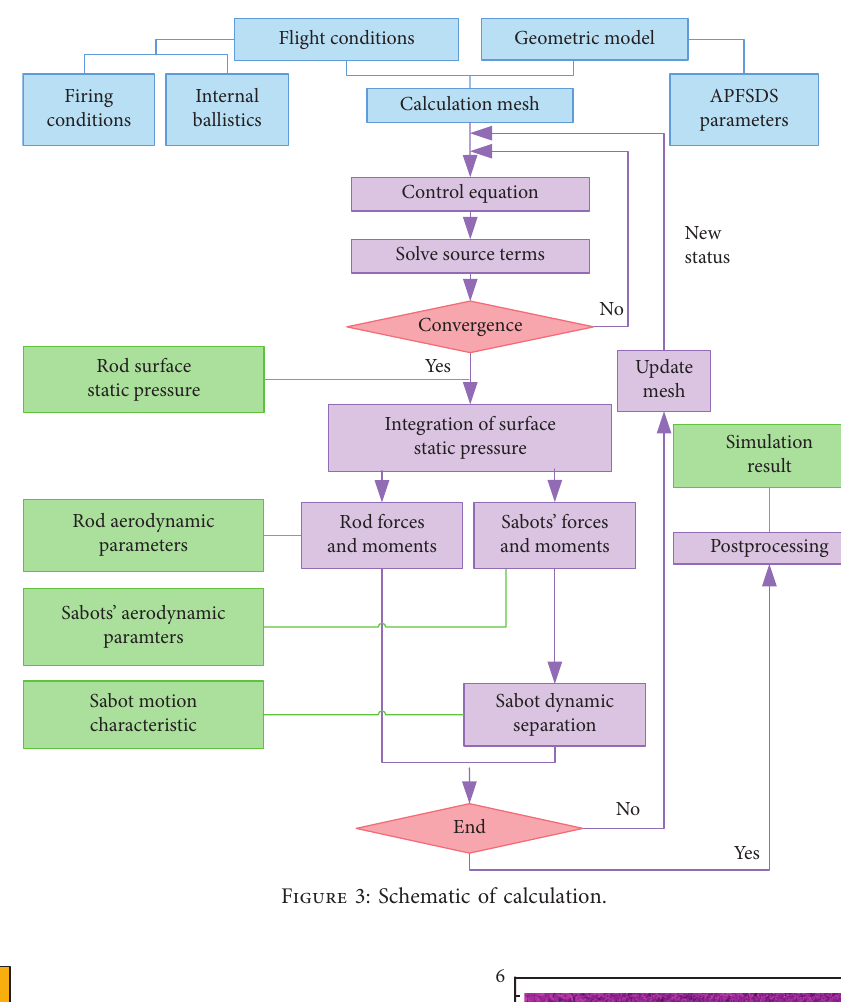
Figure 3: Schematic of